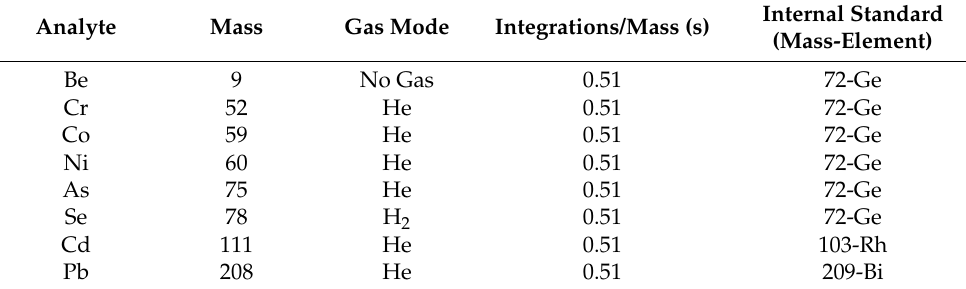
Table 4. ICP-MS mass/elements of analytes measured in each operating